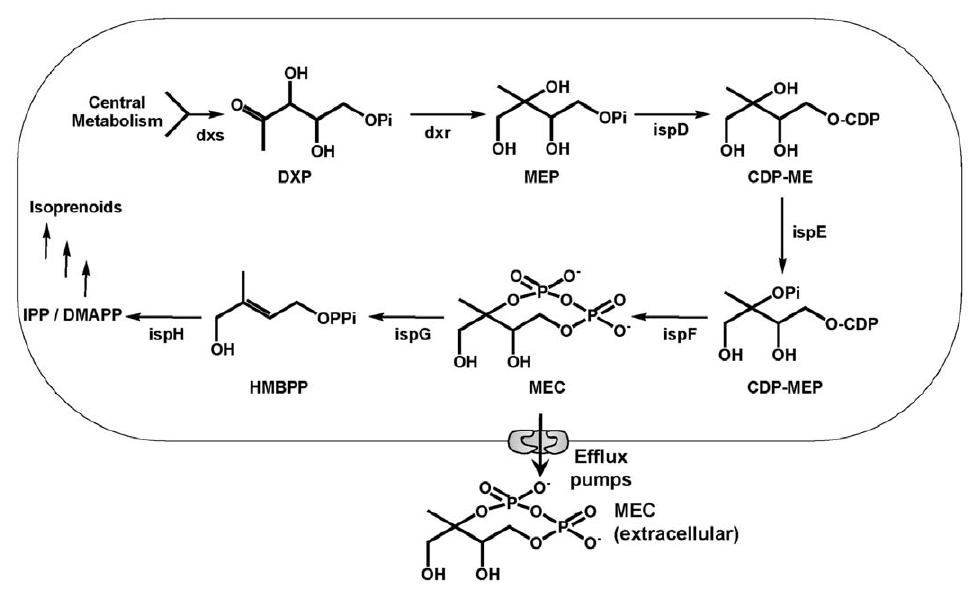
Figure 1. Metabolites and enzymes related to the 1-Deoxy-D-xylulose 5-Phosphate pathway.